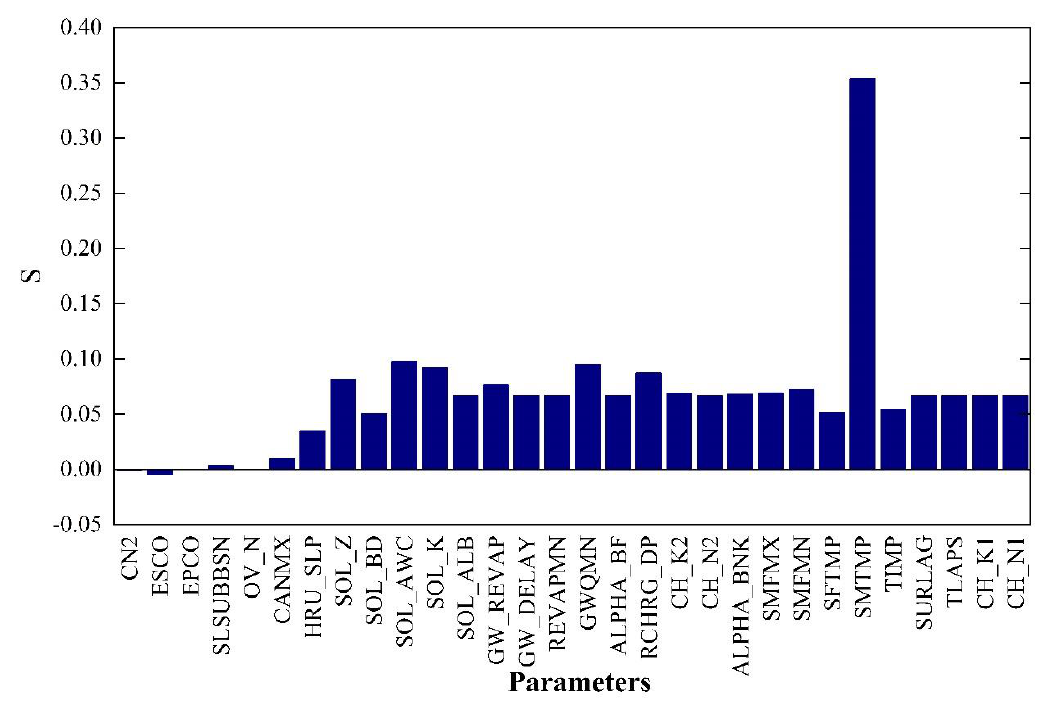
Figure 7. First-order sensitivity ( 𝑆 ) of each parameter of Sobol analysis.